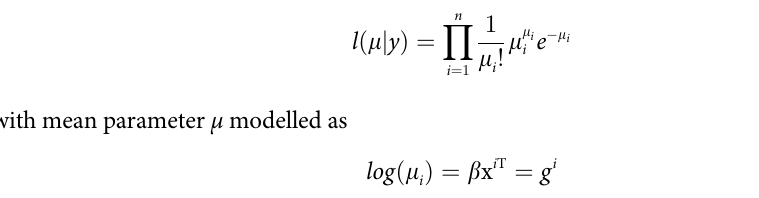
) is 40 for Experiment 1, and 32 for Experiment 2, i , are observations of independent i , y ), and likelihood: ~ P ( μ i i i